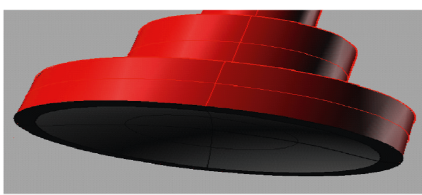
Figure 3: Plug with concave shape no 1.